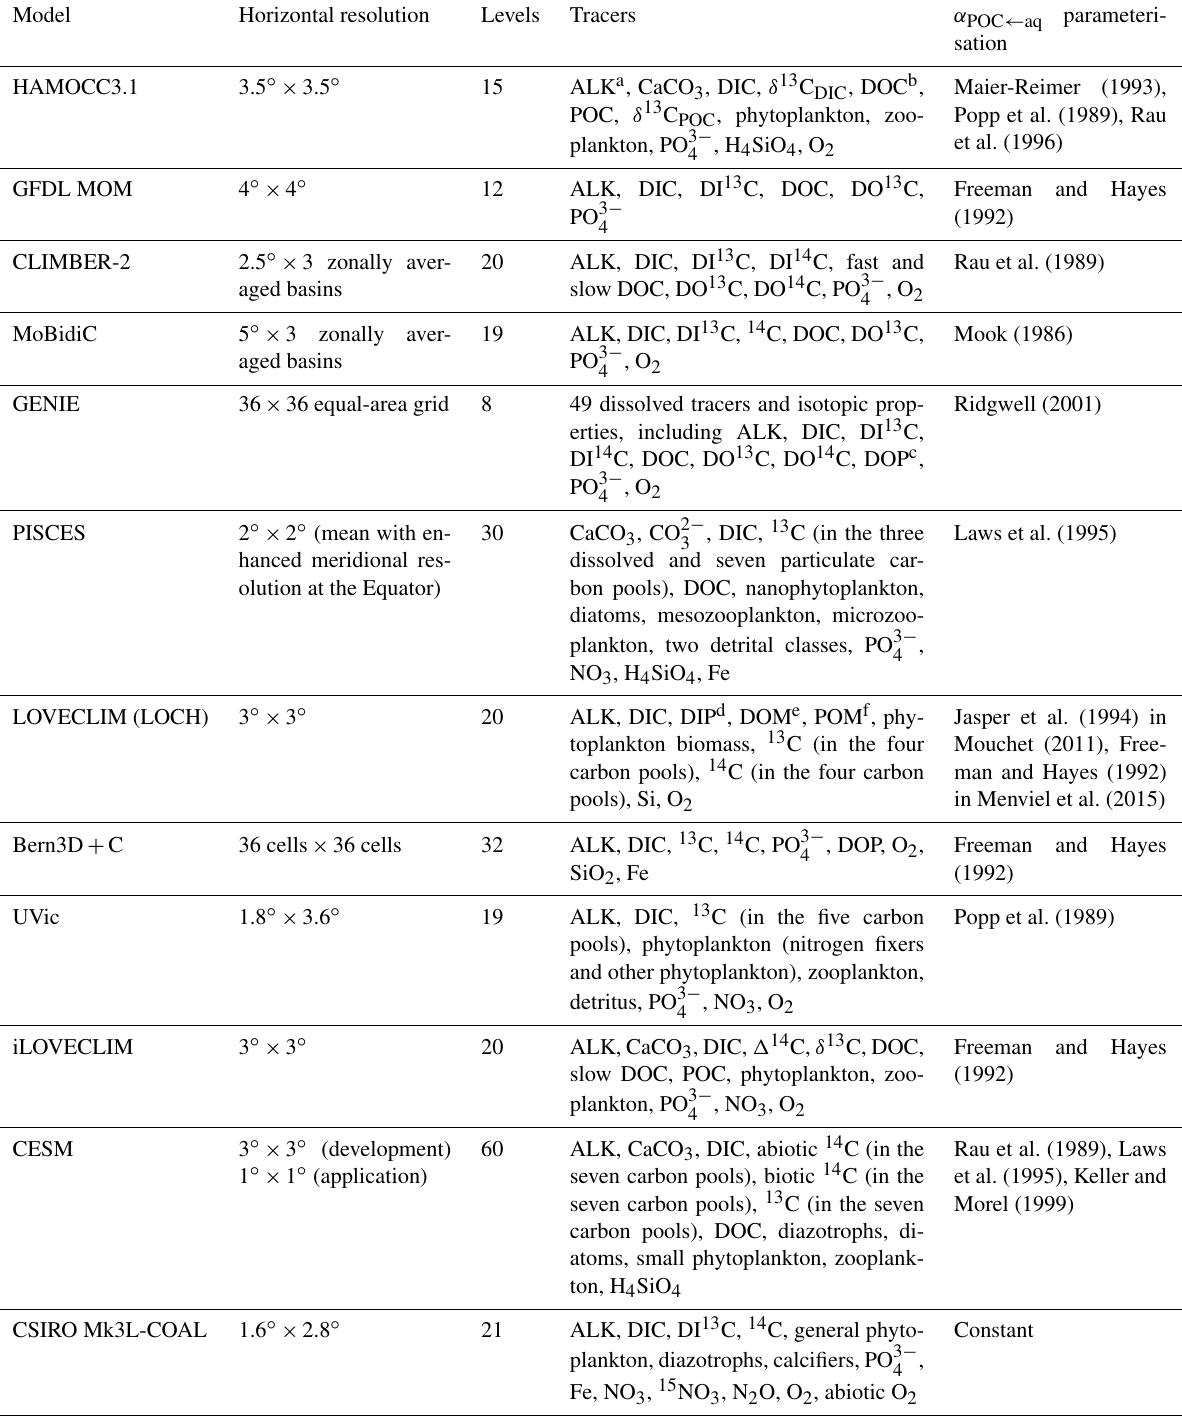
Table 1. Overview of existing 13 C-enabled